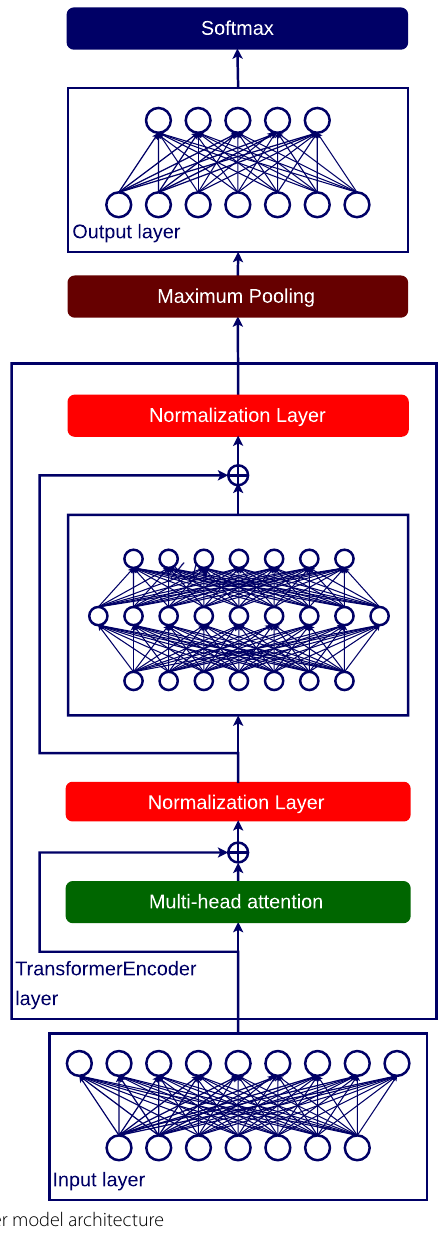
Fig. 6 TransformerEncoder model architecture